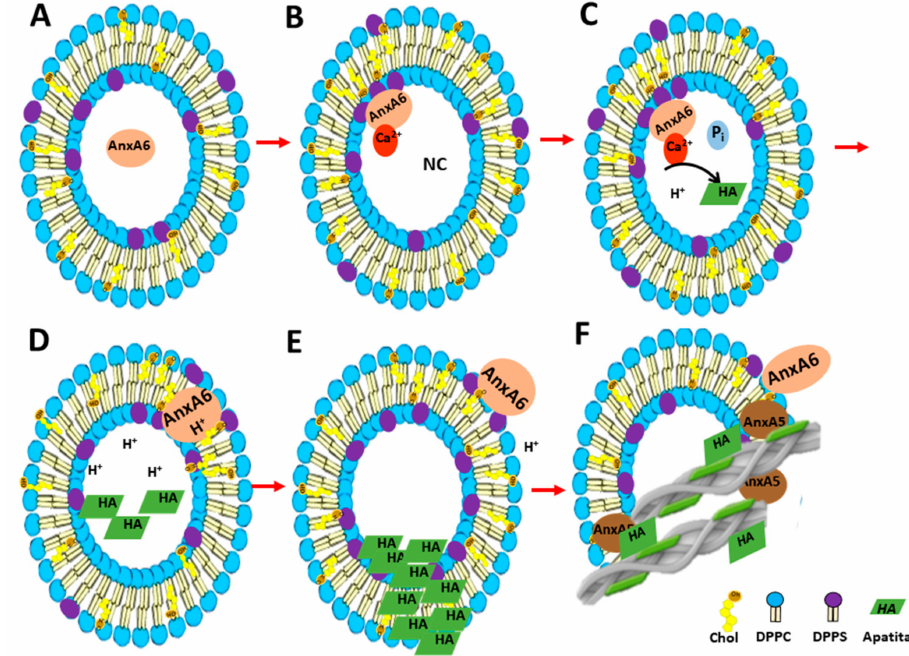
Figure 5. Representation of the action mechanism of annexins during MV-mediated mineralization: ( A ) AnxA6 can be localized in the lumen of MVs at low calcium concentrations (Ca 2+ ). AnxA5 can be bound to membrane bilayer; ( B ) Accumulation of Ca 2+ and inorganic phosphate (Pi) inside MVs favors the binding of AnxA6 to the inner leaflet of the MV membrane bilayer in a Ca 2+ - dependent manner, forming a nucleational core and initiating apatite formation; ( C ) During apatite formation, protons (H + ) are released, inducing the protonation of AnxA6 and rendering it more hydrophobic due to an ionization potential around 5.5. Protonated AnxA6 can translocate within the MV bilayer; ( D ) Apatite crystals inside the vesicles continue growing up, breaking the membrane of MVs, exposing the HA crystals to the extracellular matrix, and releasing the H + which decreases the local pH; ( E ) AnxA6 can be deprotonated and released to the external surface of MVs. ( F ) AnxA5 present in the membrane bilayer showed a high affinity to collagen binding. Thus, AnxA5 can promotes the adhesion of MVs to collagen fibers, allowing the deposition of the HA crystals on the extracellular